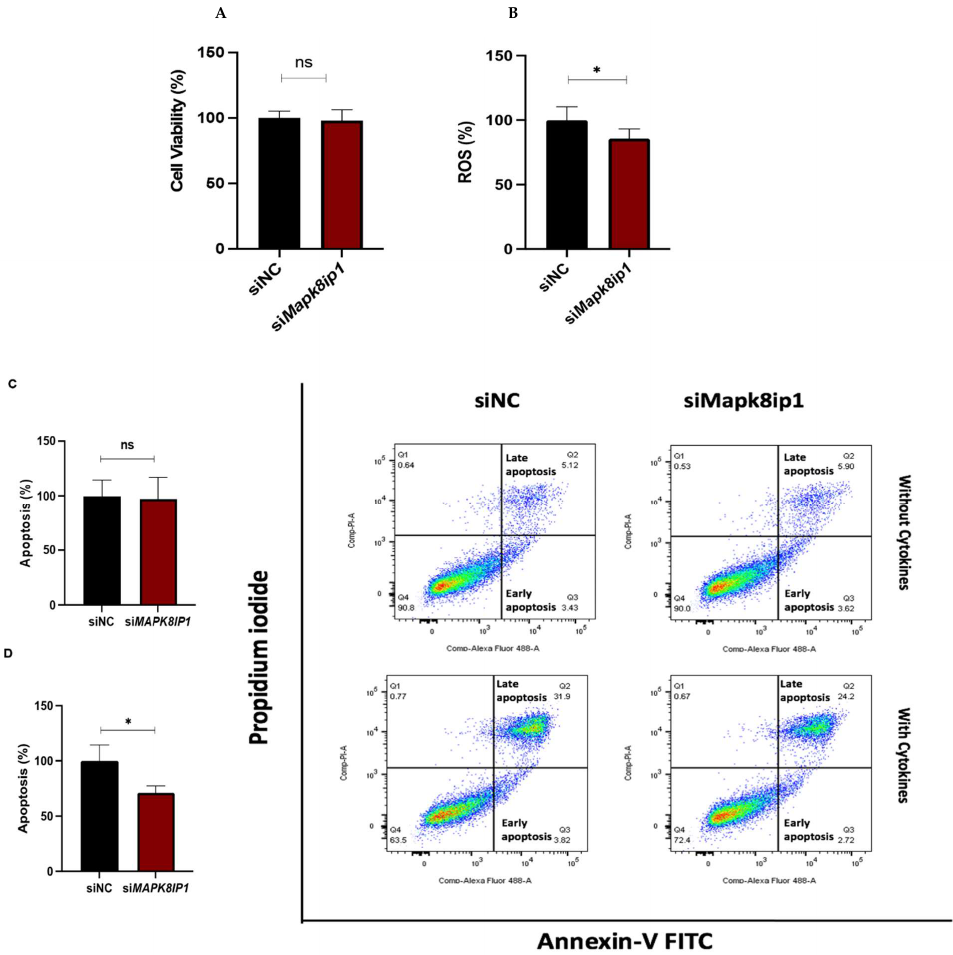
Figure 3. Influence of Mapk8ip1 -silencing on cell viability, apoptosis, and ROS production in INS-1 cells. Cells were transfected with siRNA against Mapk8ip1 (si Mapk8ip1 ) or the siRNA negative control (siNC). ( A ) Percentage of cell viability determined by MTT assay in Mapk8ip1 -silenced cells compared to control cells. Data were obtained from three independent experiments. ( B ) Detection of intracellular ROS levels in Mapk8ip1 -silenced INS-1 cells compared to control cells. Data were obtained from three independent experiments. The ROS level in the control cells was set at 100%. Analysis of apoptosis level in Mapk8ip1 -silenced INS-1 cells or negative control in the absence ( C ) or presence ( D ) of cytokine stimulation as analyzed by flow cytometry. Data were obtained from three independent experiments. * p < 0.05, ns, not significant. Bars above histograms represent SD of the mean values. Statistical analyses were performed using Student t-tests.